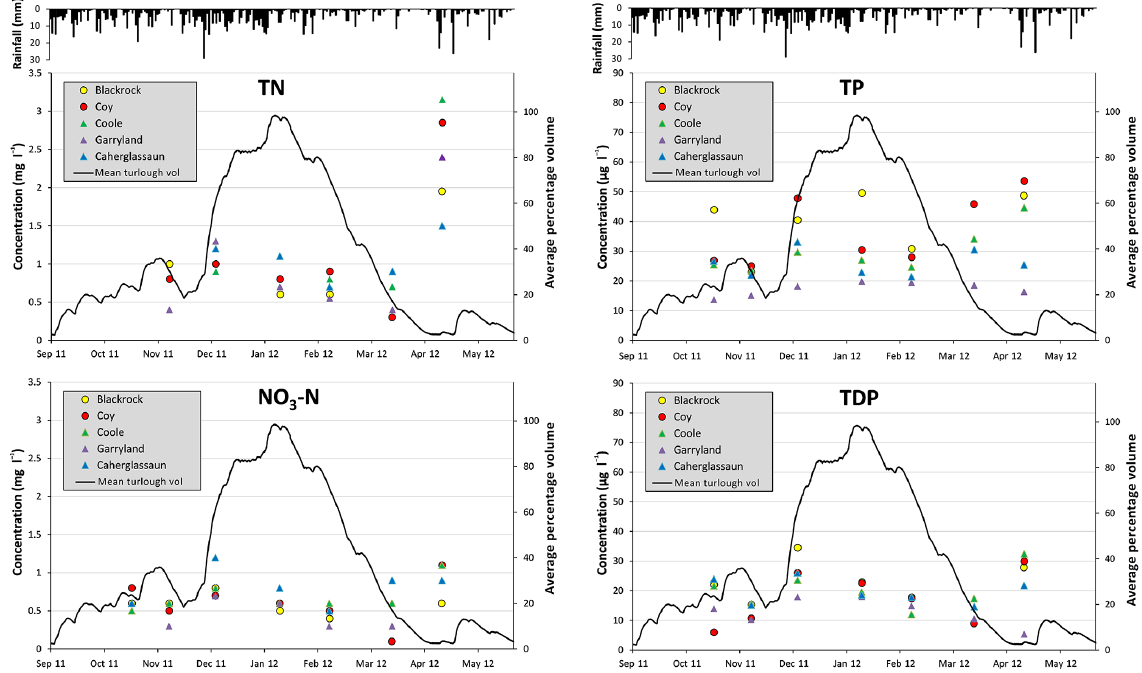
Figure 7. Concentrations of TN, NO 3 –N, TP and TDP in Blackrock, Coy, Coole, Garryland and Caherglassaun turloughs plotted together with average percentage volume of the five turloughs (i.e. volume as a percentage of the max volume over the period